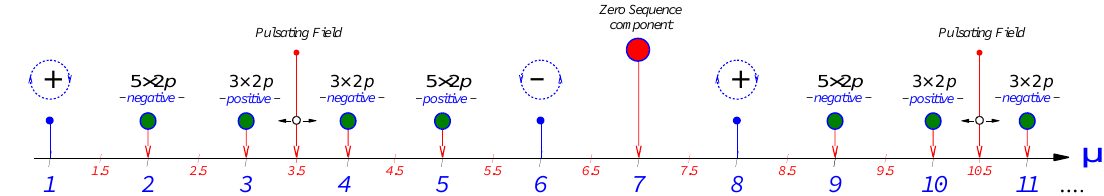
Figure 12. Time harmonics effect demonstration in five-phase machines.